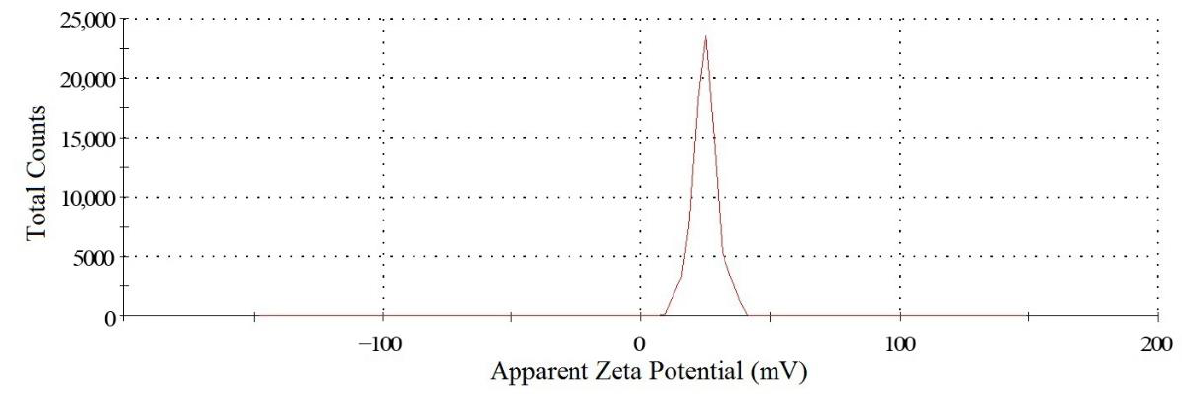
Figure 1. Surface zeta potential graph showing positive zeta potential value for NH 2 -PEO-PCL nanoparticle.